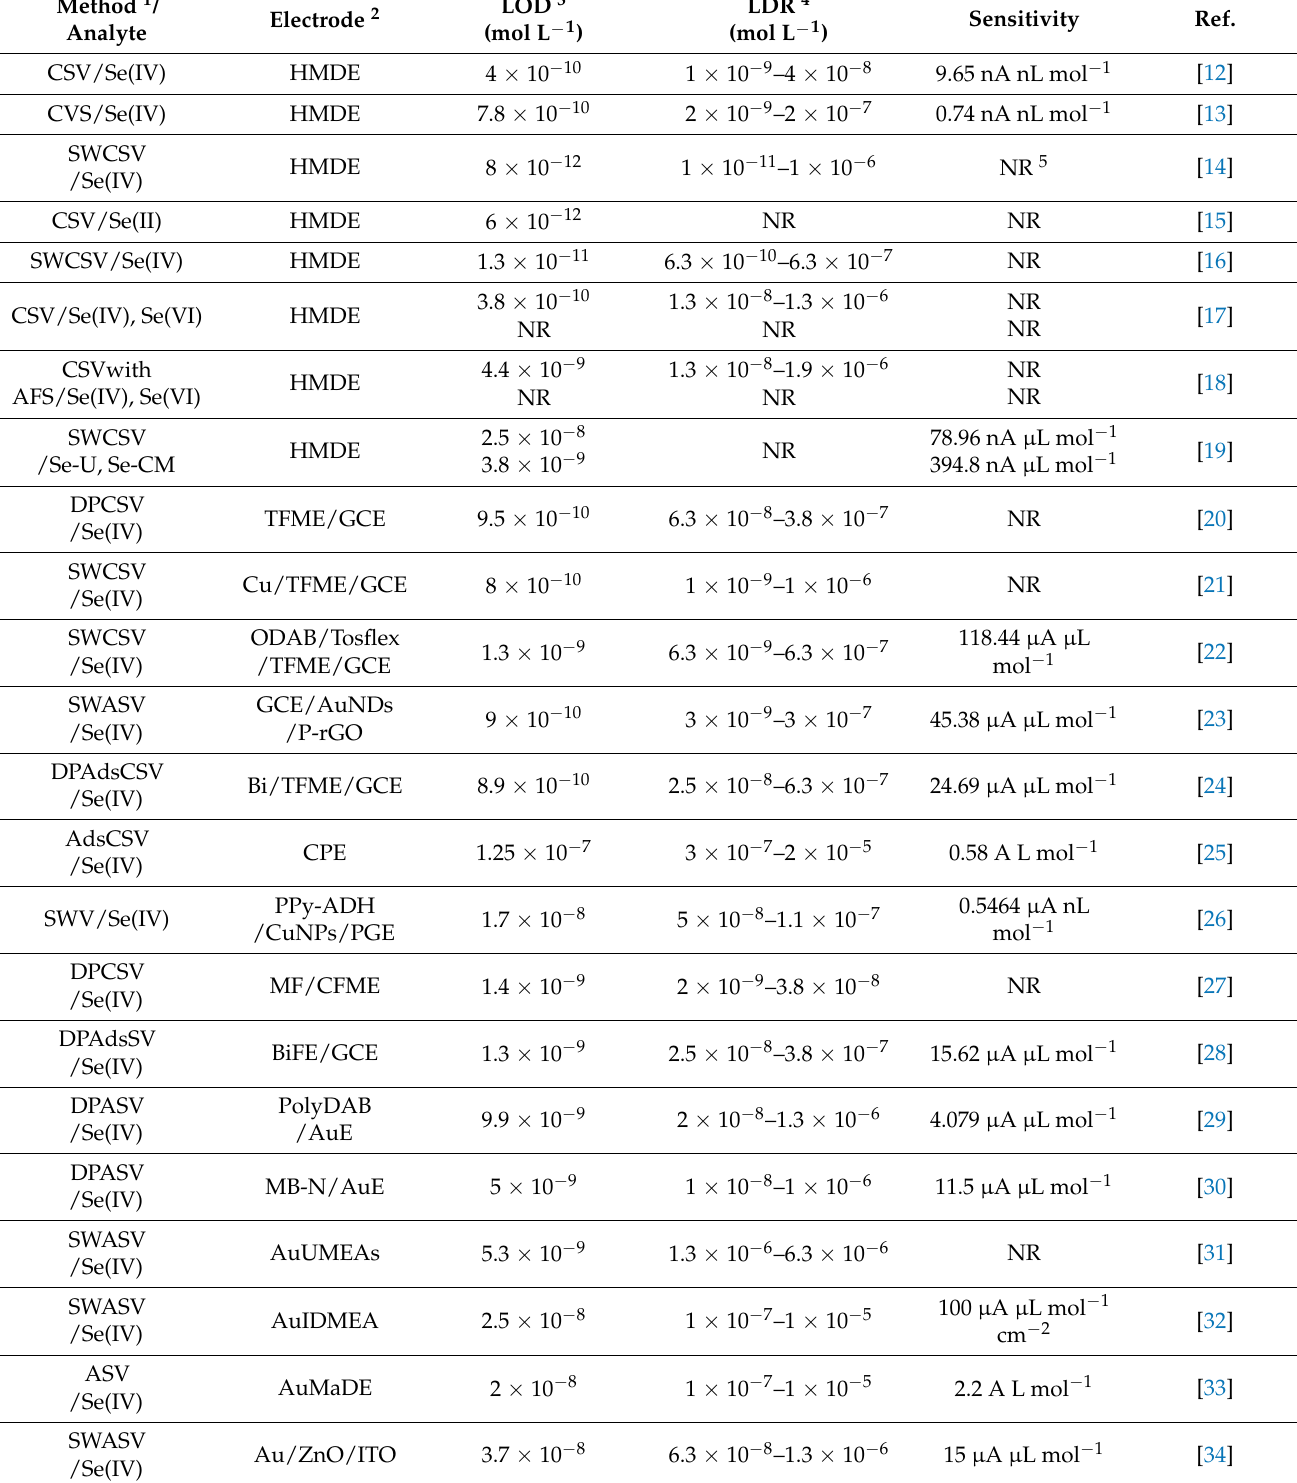
Table 1. Comparison of analytical performance of electrochemical sensors for the detection of